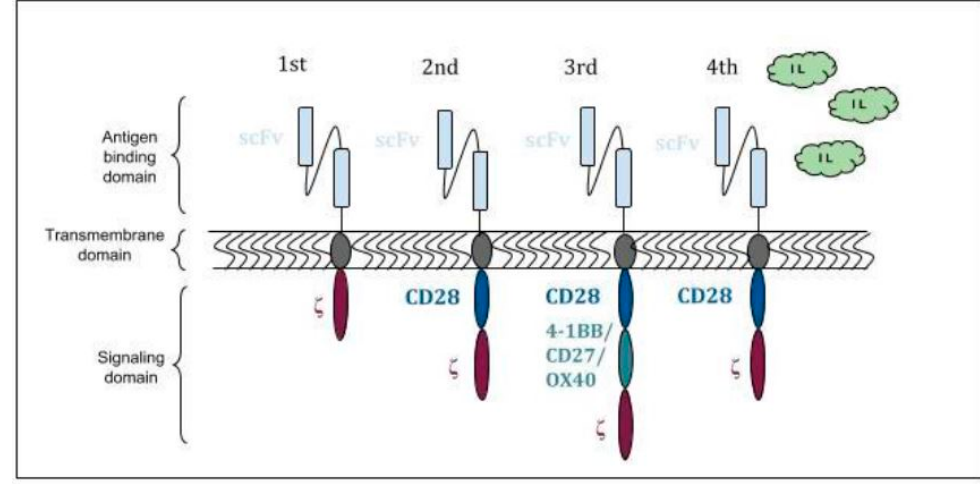
Figure 1. Chimeric antigen receptor (CAR) structure and generations.